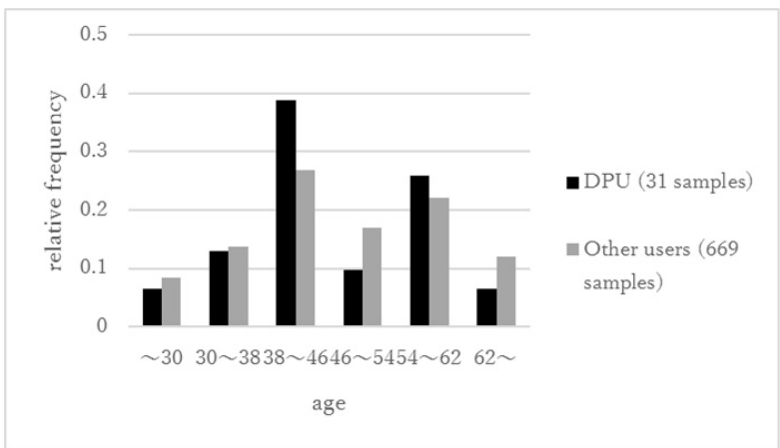
Figure 1. Histogram of consumer knowledge Source: Created by author from survey